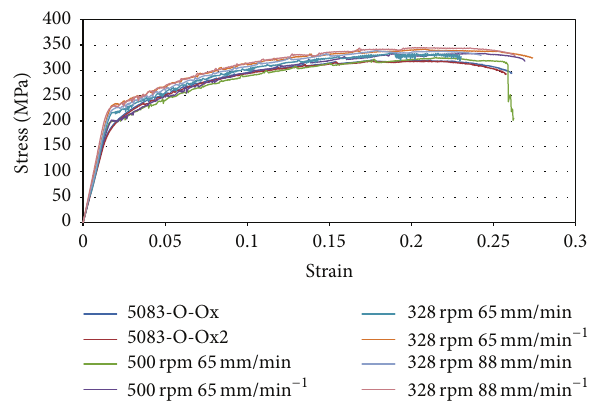
Figure 21: Stress strain curves for specimens with and without processing.